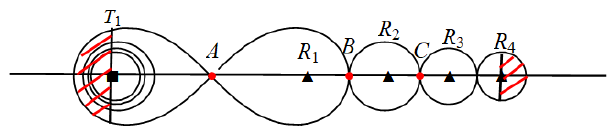
Figure A5. External coverage area of T − R n .